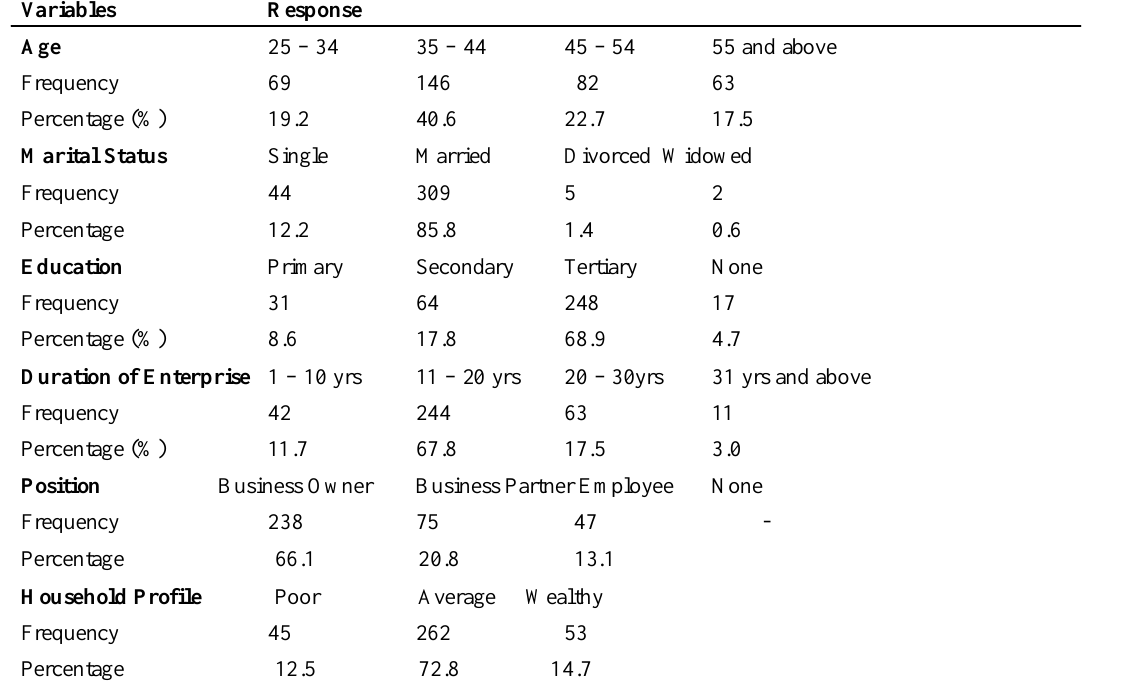
Table 1: Demographic data of respondents